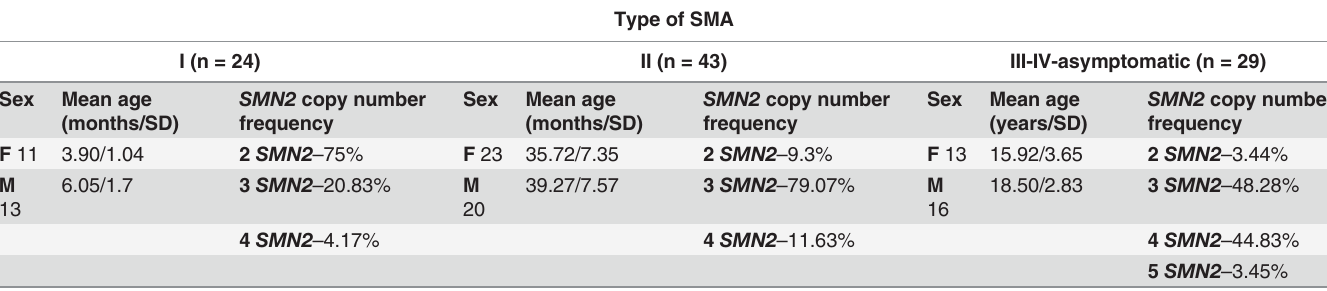
Table 1. SMA patients included in methylation analysis.